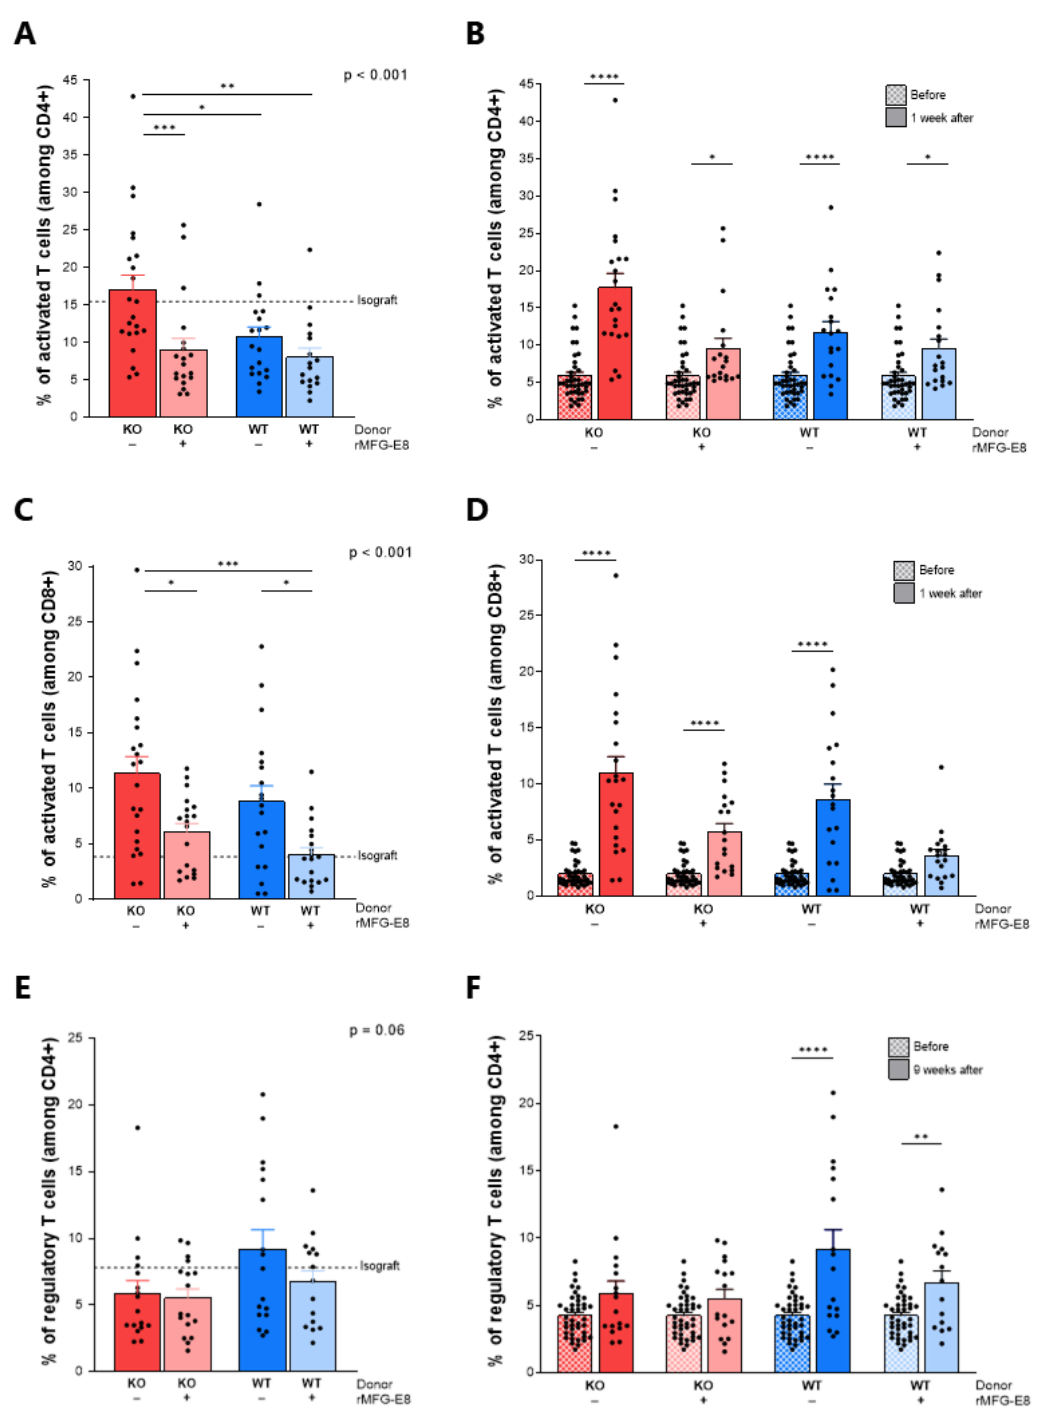
Figure 4. Effect of MFG-E8 on systemic T-cell activation. Systemic T-cell activation was assessed by flow cytometry (gating strategies are shown in Supplementary Figure S1). Activated CD4 + CD44 + T cells 1 week after transplantation ( A ) and comparison with levels before transplantation ( B ). Activated CD8 + CD44 + T cells 1 week after transplantation ( C ) and comparison with levels before transplantation ( D ). CD25 + FoxP3 + regulatory T cells 9 weeks after transplantation ( C ) and comparison with levels before transplantation ( D ). In figures ( A , C , E ), p -values (upper right corner) indicate the overall ANOVA result. In figures ( B , D , F ), hatched bars represent pre-transplant data. Solid bars represent post-transplant data. * p < 0.05, ** p < 0.01, *** p < 0.001, **** p <